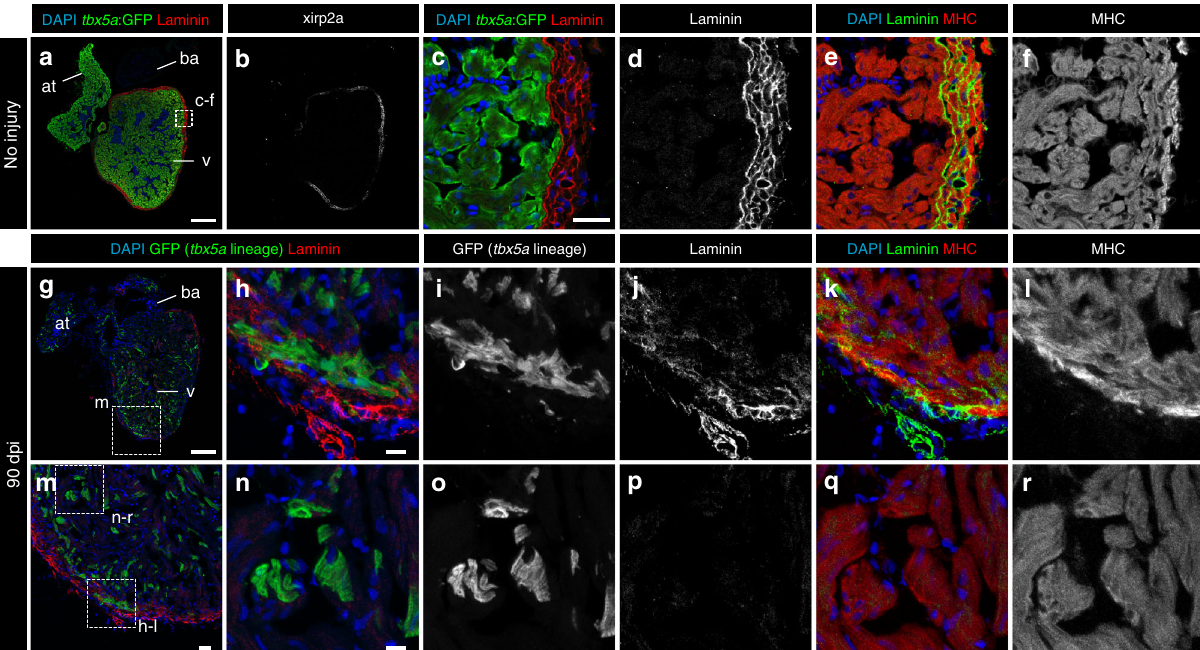
Fig. 9 Trabecular tbx5a -derived cardiomyocytes within the cortical myocardium are surrounded by Laminin. Immuno fl uorescence with anti-Laminin, anti- GFP, and anti-Myosin Heavy Chain (MHC) on ventricle sections. a – f Uninjured adult tbx5a : GFP ventricle. Laminin expression was observed in the cortical layer but not in the trabecular layer showing a complementary pattern with tbx5a:GFP ( n = 3/3). g – r Double transgenic tbx5a : mCherry-p2a-CreER T2 ; ubb : loxP- lacZ-loxP-GFP adult fi sh were treated with 4-Hydroxytamoxifen (4-OHT) from 84 to 72 and 60 to 48 hours before cryoinjury. Hearts were fi xed